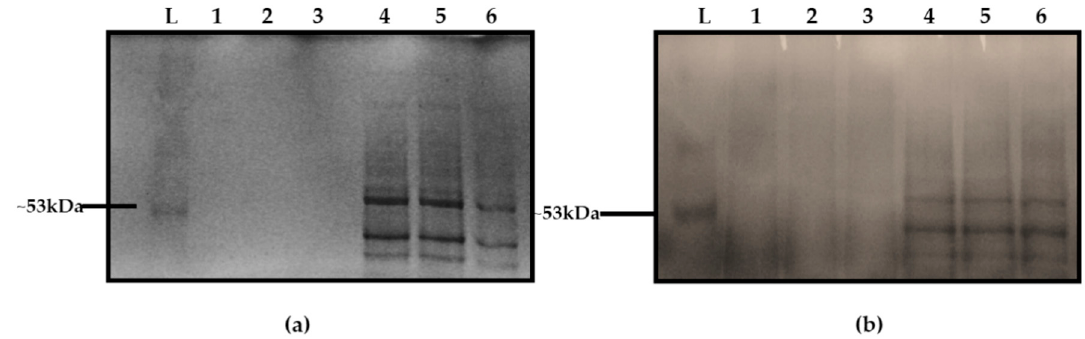
Figure 3. Staining of the EPS of the L. monocytogenes crude extract with Coomassie blue ( a ) and methylene blue ( b ). Lane L in both panels is the ladder. In panels ( a , b ) samples were treated with pronase, (lanes 1, 2, 3) whereas samples in lanes 4, 5 and 6 were not.